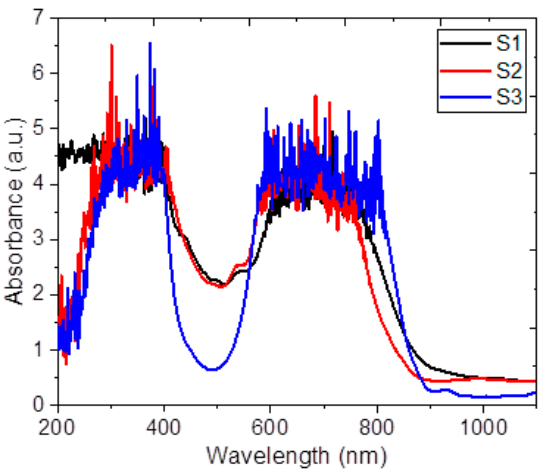
Figure 3. Ultra violet (UV)-vis spectra of S1 , S2 and S3.